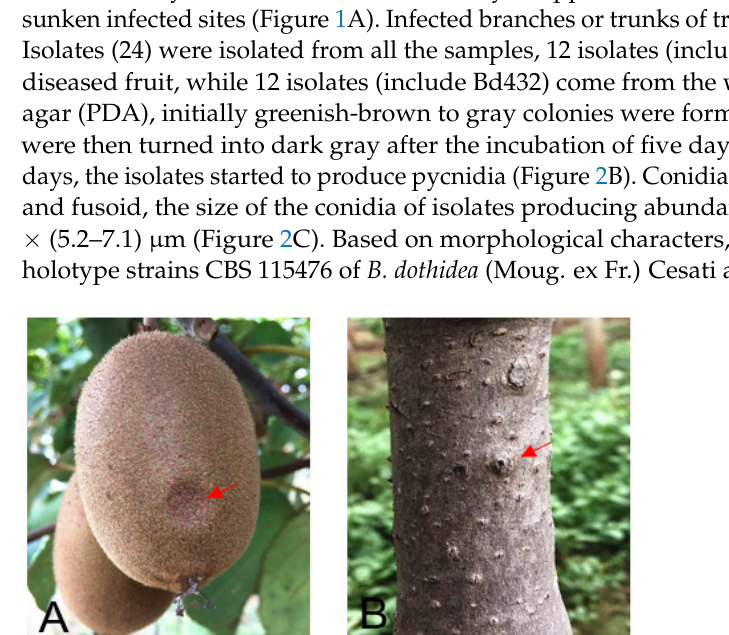
Figure 2. Morphologic characteristics of Botryosphaeria dothidea . Bd 431 comes from the diseased fruit ( left ), Bd432 comes from the wart ( right ). ( A ) The B. dothidea phenotype following a 5-day culture period on potato dextrose agar (PDA). ( B ) Pycnidia formation of B. dothidea on PDA. ( C ) Conidial morphology of B. dothidea . 2.2. Molecular Identification The use of ITS1/ITS4 primers caused the amplification of the expected bands in Bd431 and Bd432 isolates, which was in accordance with the classification of the mor- phological features employed in this research. For BD431 isolate, the region sequence of ITS rDNA revealed 100% homology to B. dothidea isolate (AF027747) (Figure 3), and the sequence was deposited in Genbank with accession number MW547773. The β -tubulin gene and the EF1 α gene were successfully amplified for the isolate, the β -tubulin se- quence analysis of the isolate revealed 100% homology to B. dothidea isolate (KY393166), and the EF1 α gene also has 100% homology to B. dothidea isolate (GU294736). Moreover, the BD432 isolate has the same result. The results of ITS and β -tubulin and EF1 α identi- fication were found to be identical with analysis of microscopic and morphological characteristics.